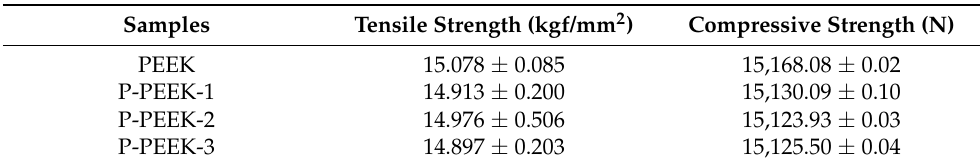
Table 1. Mechanical strength of P-PEEK implant treated with a mixed acid of sulfuric acid and nitric acid under ultrasound for 90 s *.